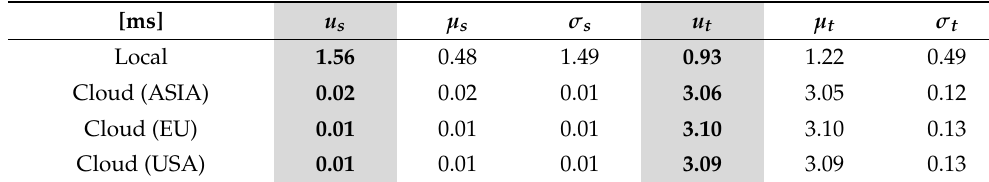
Table 1. NTP synchronization and timestamp